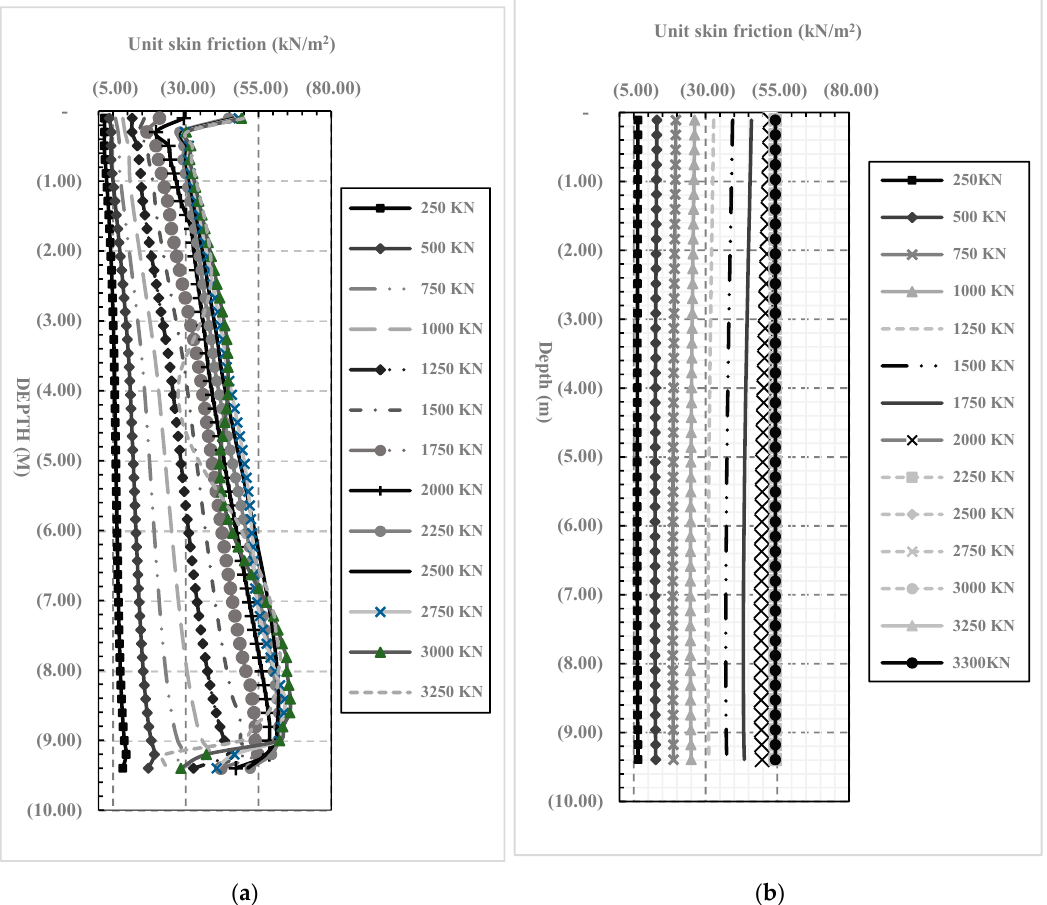
Figure 14. Results of the average values of unit skin friction obtained using numerical analysis. ( a ) Drained analysis [10]. ( b ) Un-drained analysis.